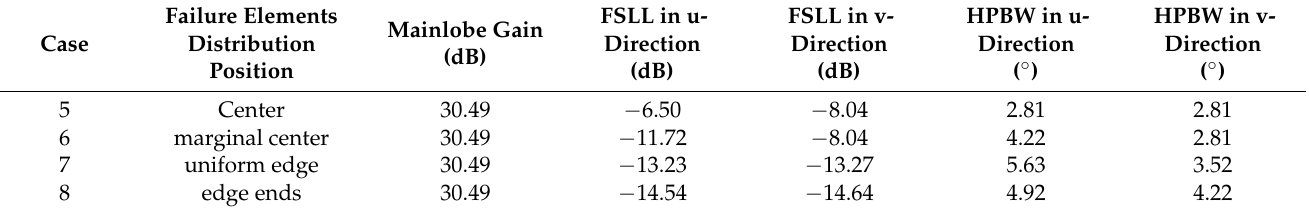
Table 8. Electrical performance parameters in the transmitting mode in different failure elements distribution conditions.